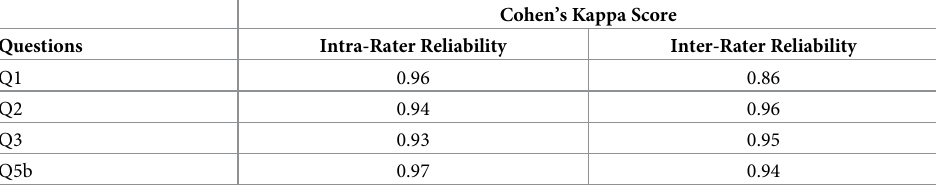
Table 4. Cohen’s kappa scores for intra- and inter-rater reliability of questions Q1, Q2, Q3, and